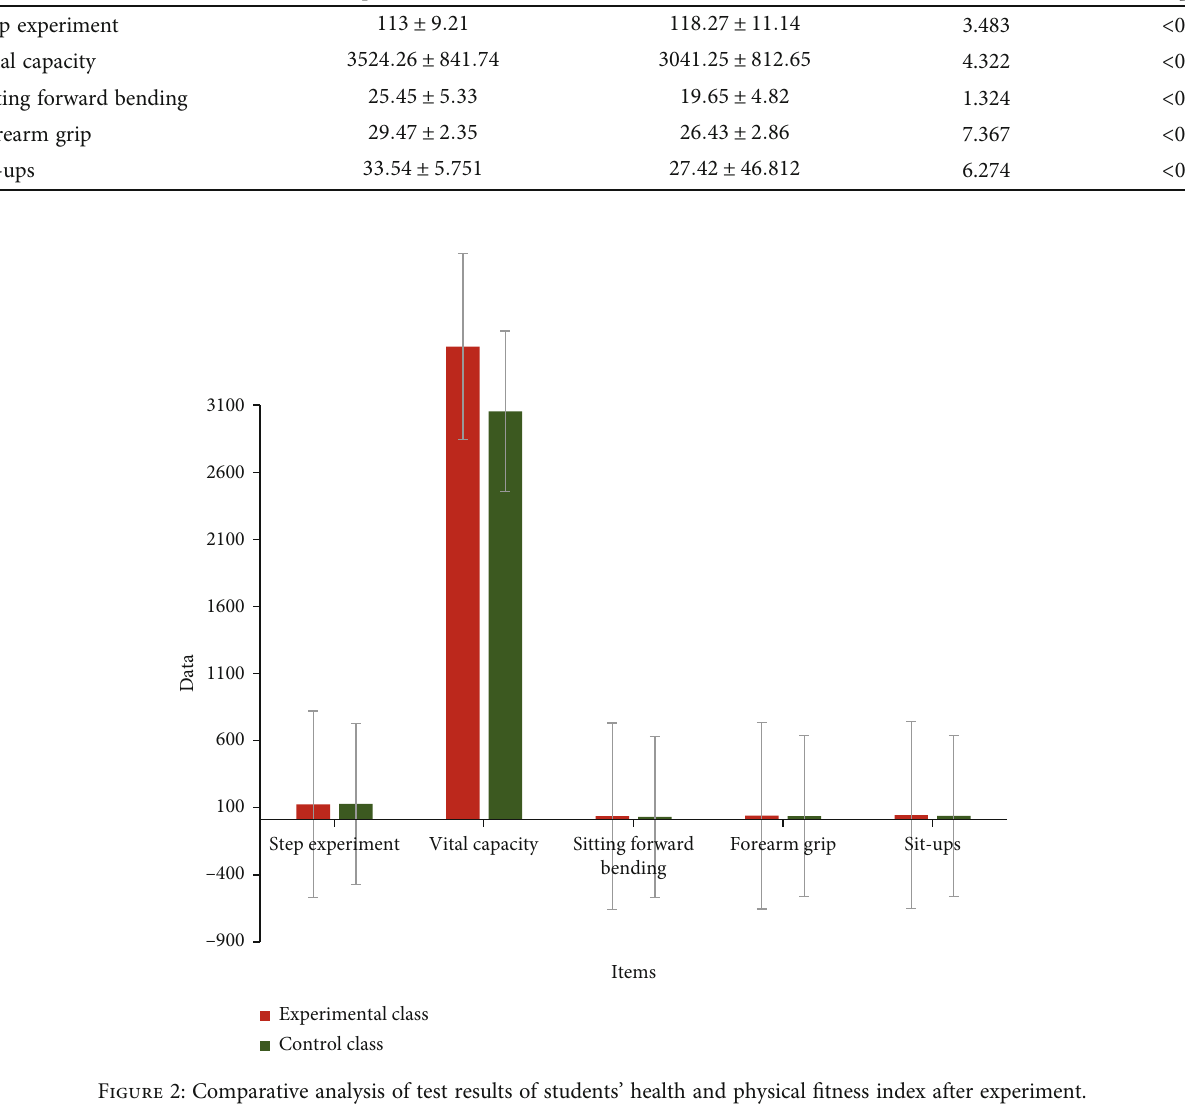
Table 2: Comparative analysis of test results of students ’ health and physical fi tness index after experiment. Test